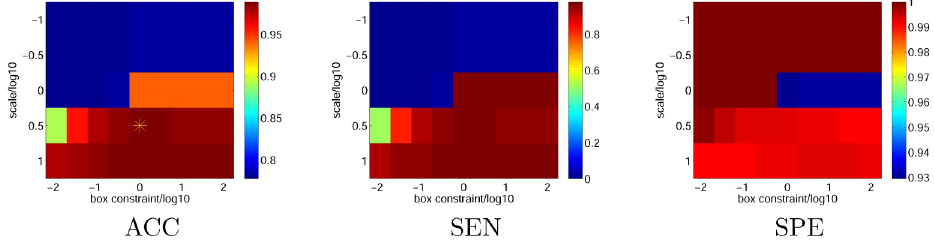
Fig 5. Ten-fold cross validation performance with different scale and box constraint parameters.